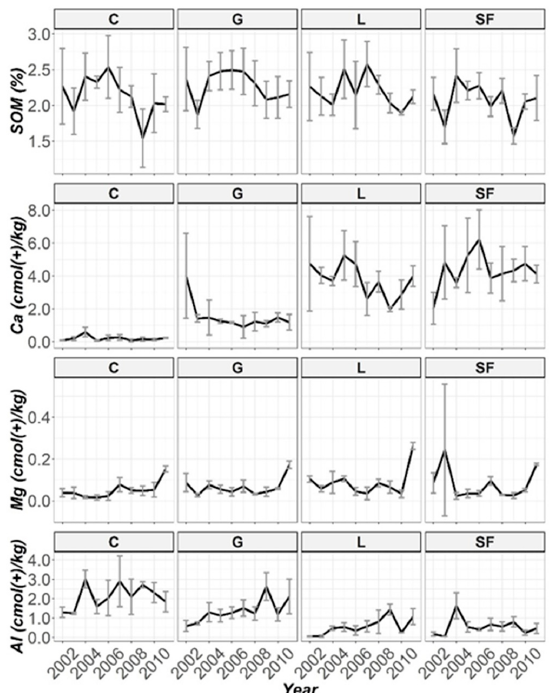
Figure 3. Temporal evolution of SOM, Ca, Mg and Al in the Ap1 horizon throughout the ten years of soil monitoring (2002–2011).